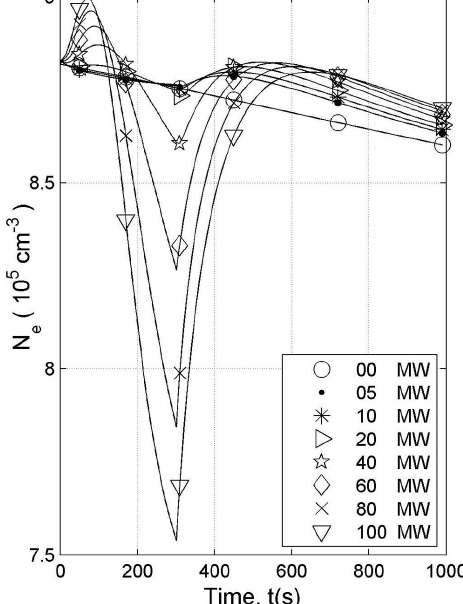
Fig. 8. The time variations of the electron concentration (in units of 10 5 cm − 3 ) at the level h = 235km. The results are given for the same cases as in Fig.